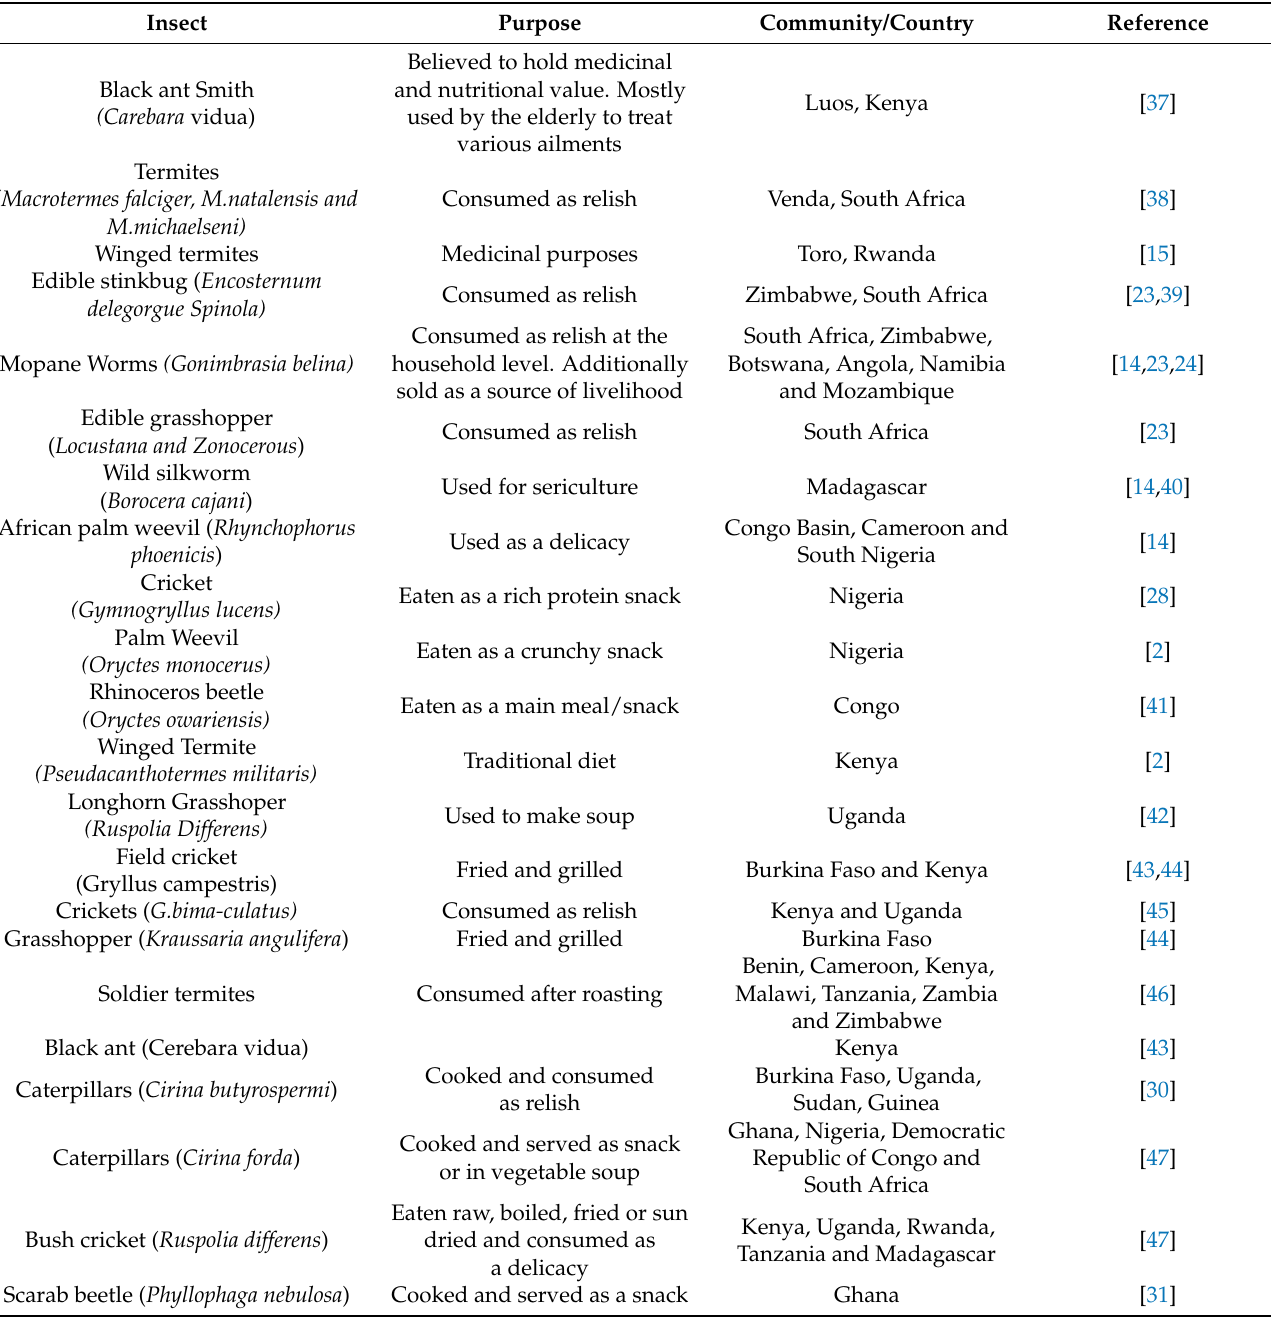
Table 1. Common edible insects of